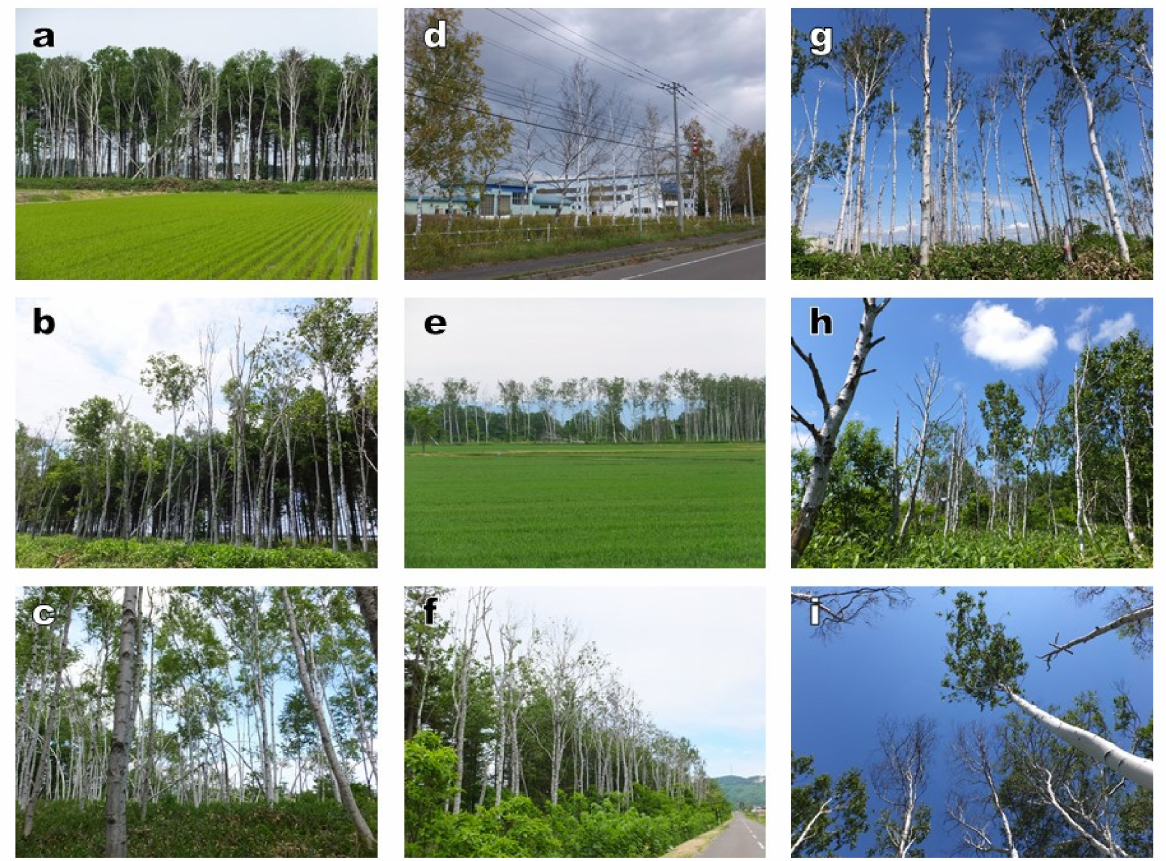
Figure 3. Study plots of the degraded stands in Iwamizawa, Mikasa, Shinshinotsu, and Tsukigata. ( a ) Plot 24 on 15 June 2017, ( b ) Plot 25 on 16 June 2017, ( c ) Plot 26 on 16 June 2017, ( d ) Plot 29 on 16 October 2016, ( e ) Plot 30 on 7 June 2017, ( f ) Plot 31 on 7 June 2017, ( g ) Plot 37 on 16 June 2017, ( h ) Plot 46 on 13 June 2017, ( i ) Plot 51 on 14 June 2017. Note that we have no photos of Plot 21 in the growing season because the investigation was carried out on 29 March 2017. Crown vigor in Plot 21 was observed during the growing season in